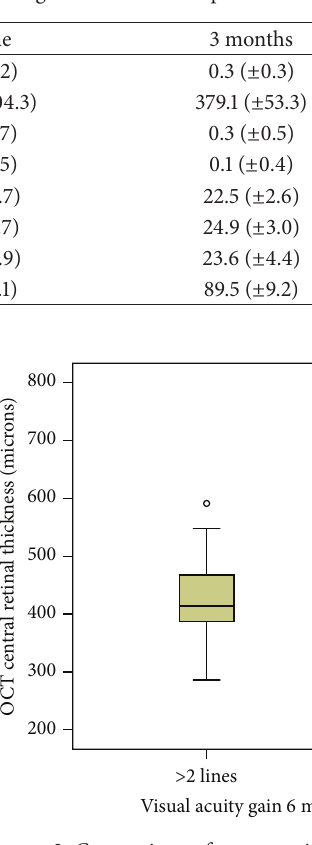
Figure 3: Comparison of preoperative mean central retinal thick- ness between patients with more than 2 lines ( 𝑛 = 30 ) and patients with less ( 𝑛 = 12 ) than 2 lines of visual acuity gain ( 𝑝 < 0.05